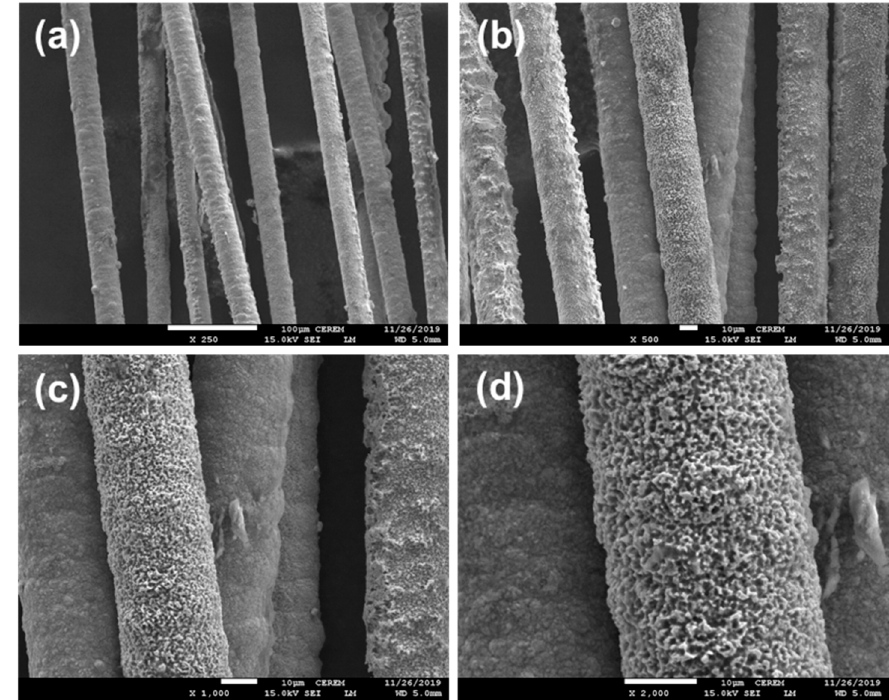
Figure 11. SEM images with different magnifications of the carbon long fibers copper-coated using the electroplating copper coated method with a current density of 12 μ A/cm 2 for 5 min in the electroplating cell. ( a – d ) Low to high resolutions.